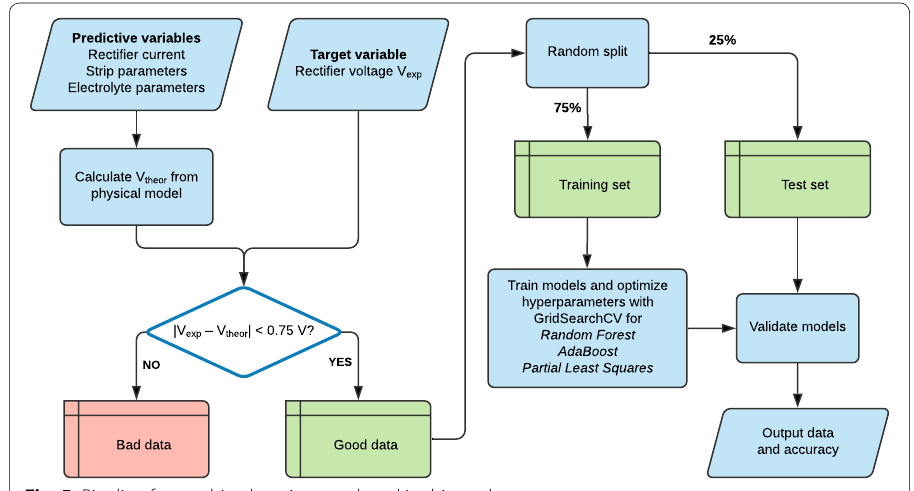
Fig. 5 Pipeline for machine learning employed in this